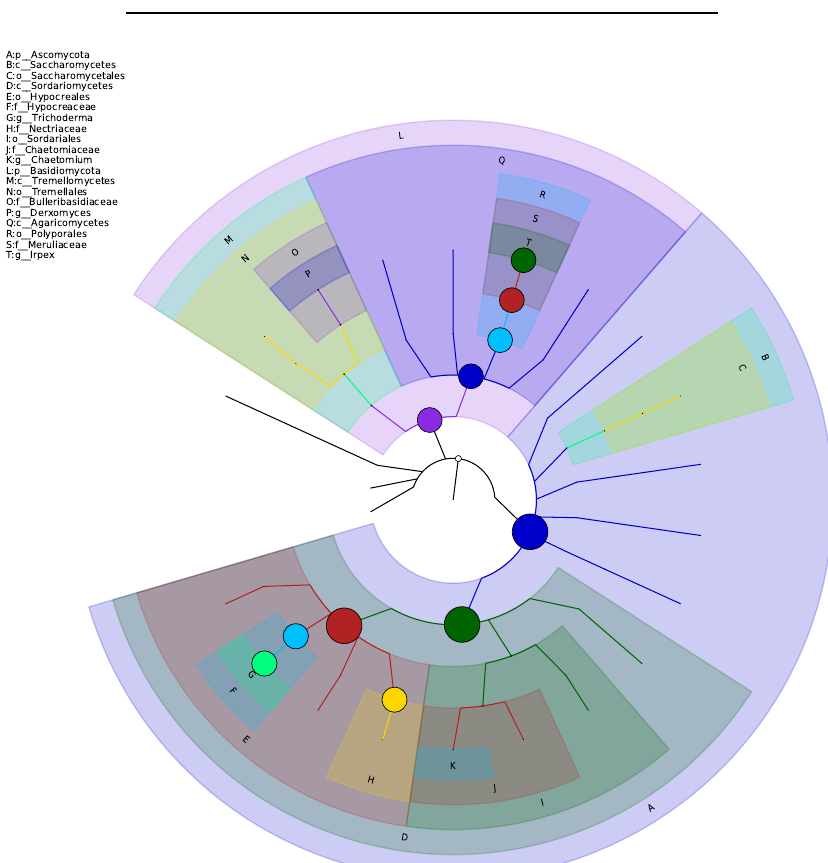
Figure 3. GraPhlAn-based classification hierarchical tree map chart of dominant fungi communities in the debitterizing water of apricot